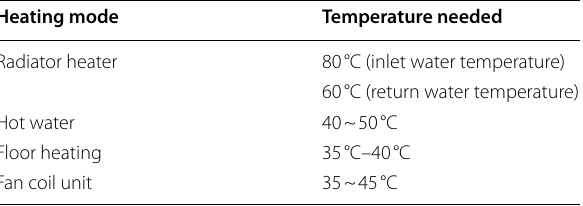
Table 2 Temperature range of buildings’ heat